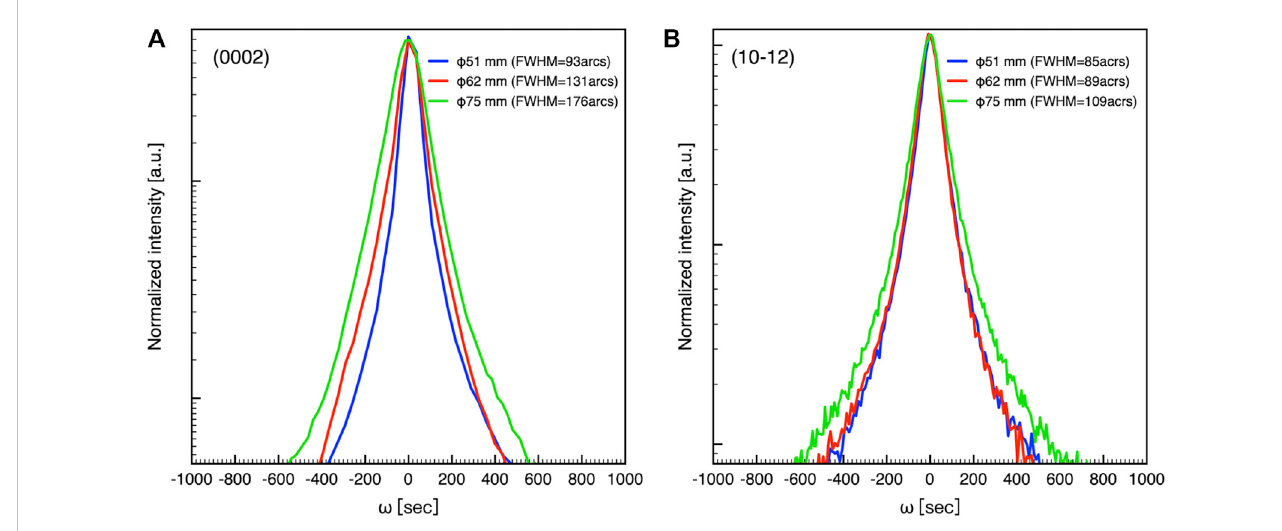
FIGURE 5 Comparison of HRXRD rocking curves of the Φ 51, Φ 62, and Φ 75 mm AlN substrates: (A) symmetric (0002) and (B) asymmetric (10 – 12) re fl ections.